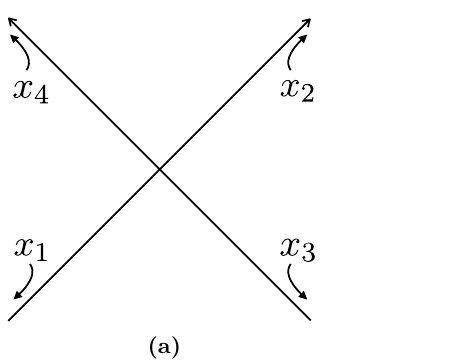
Figure 2. The figure on the left corresponds to taking the Regge limit in position space. Here we send the four operators to null infinity such that x 2 figure on the right gives the same limit in CFT cross-ratio space. In momentum space these limits correspond to taking the large t Regge